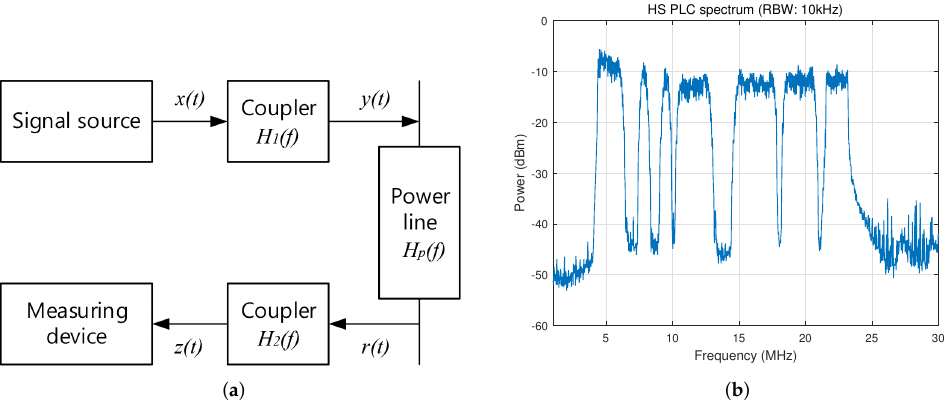
Figure 4. Model of the PLC system. ( a ) Measurement signals for the PLC system. ( b ) An example of the power spectrum of the HS PLC signal at the coupler output y ( t )